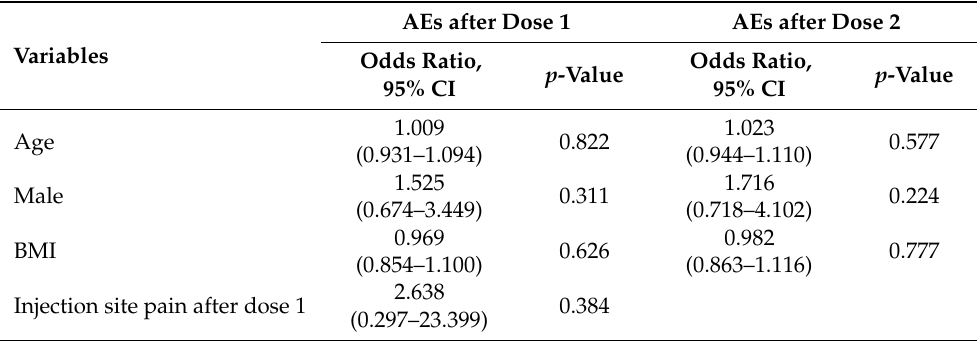
Table 4. Multivariate analysis for predictive factors of strong antibody response four weeks after administration of the second dose of mRNA-1273